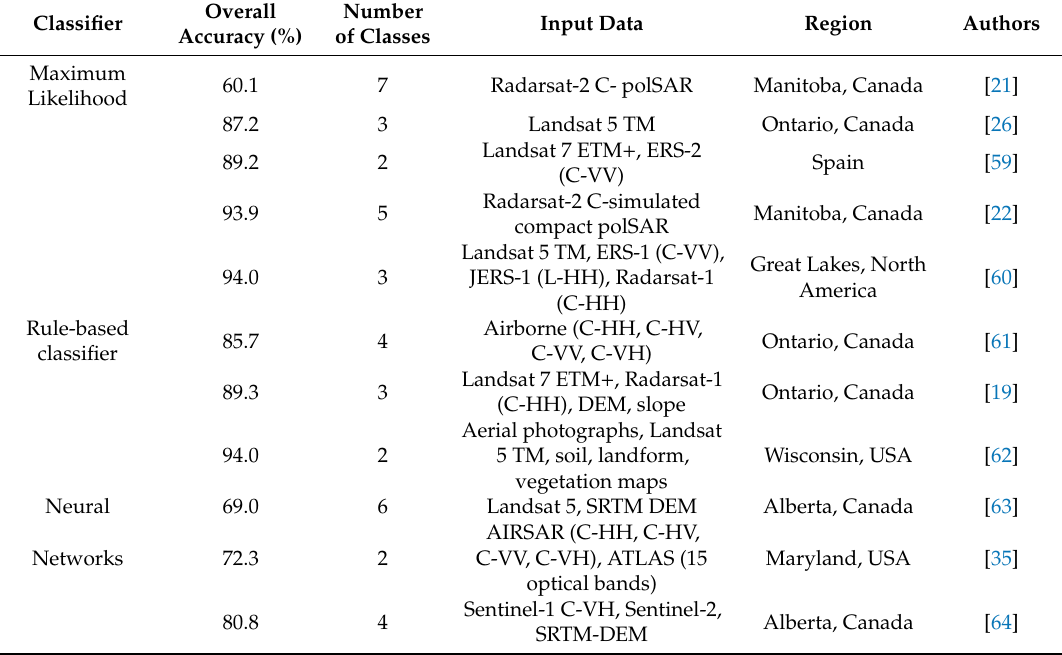
Table 2. Comparison of the best overall accuracy (%) achieved in previous studies that used various classifiers for wetland mapping, as a function of the classifier, number of classes, and the input datasets.